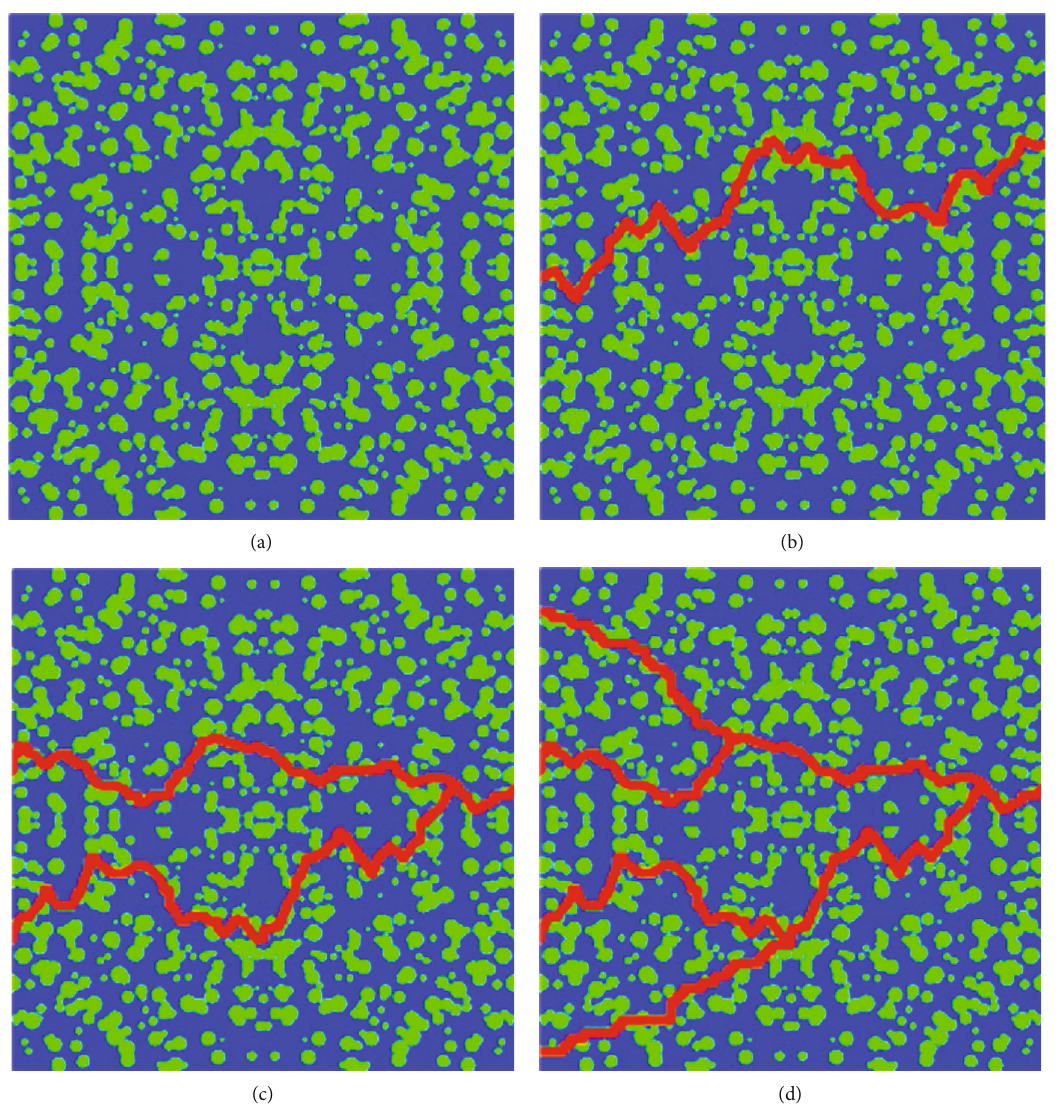
Figure 6: The reconstructed coal matrix with di ff erent fracture